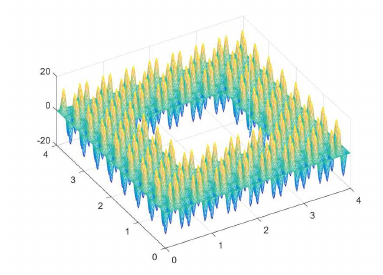
Figure 5. Exact solution u 2 for h = 1 / 64.